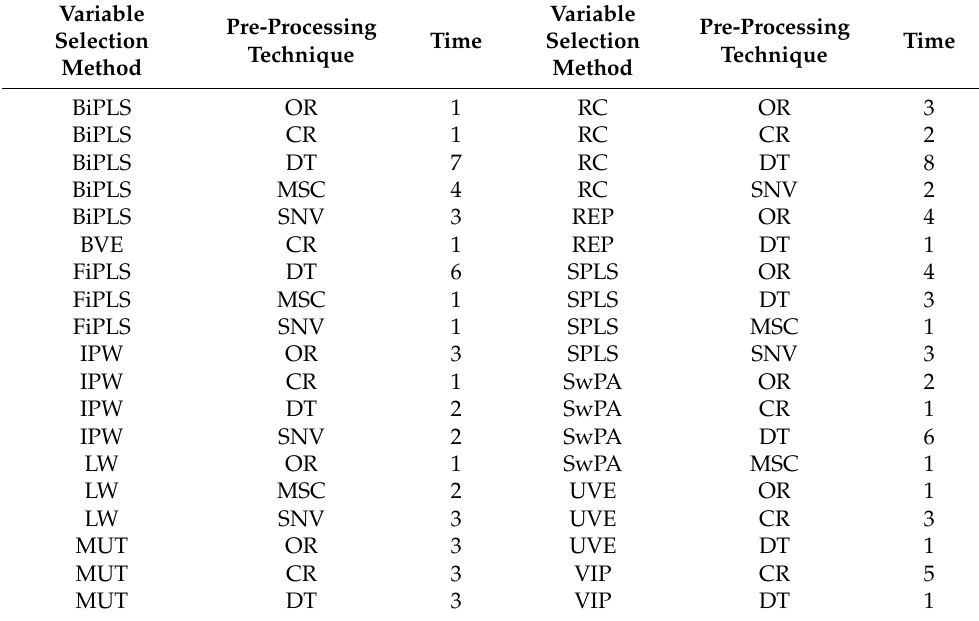
Table 5. Optimal combinations of variable selection method and preprocessing technique after 100